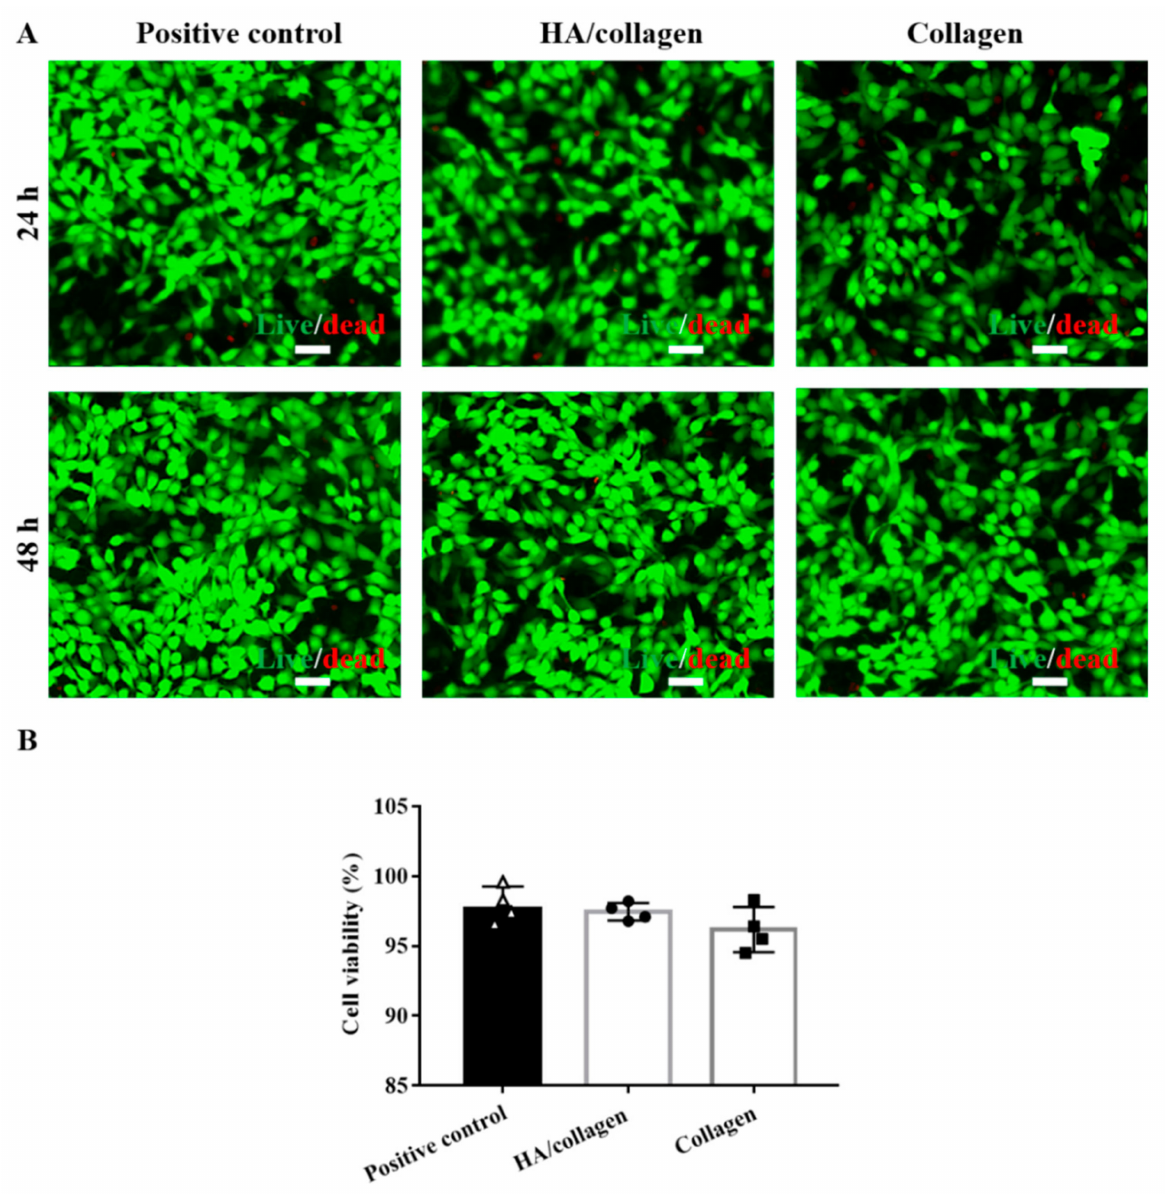
Figure 5. In vitro cytocompatibility analysis. ( A ) Fluorescence microscopy graphs of stained mouse PAECs with and without crosslinked nanofiber films after 24 and 48 h of culture. Scale bars, 50 µ m. ( B ) The cell viability of mouse PAECs with and without crosslinked nanofiber films after 48 h of